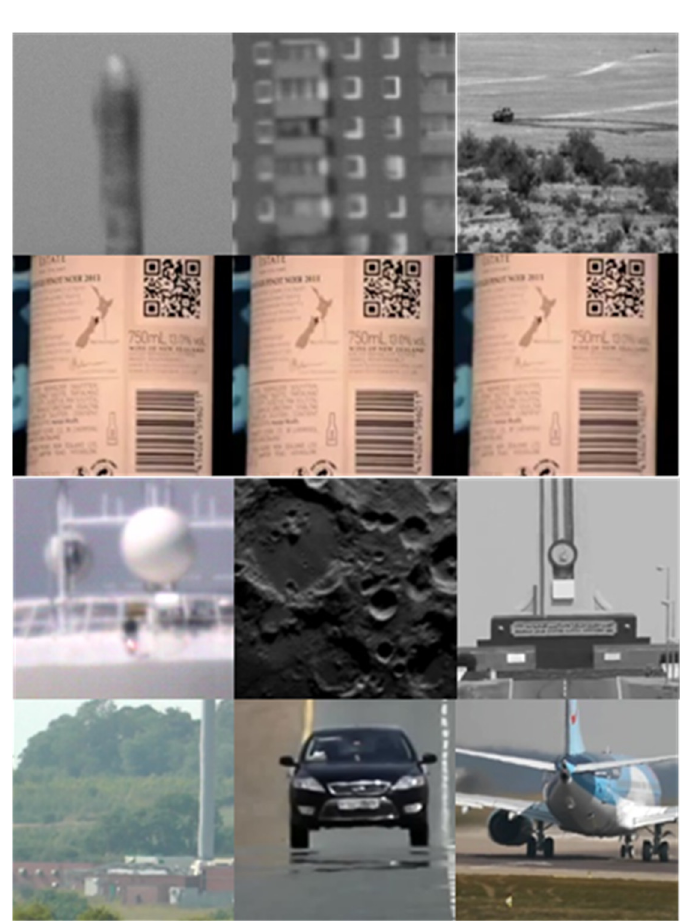
Figure 7. Sample frames from each video. First row: Chimney, Building, SENSIAC. Second row: Barcode #1–#3. Third row: Water tower, Moon, Monument. Fourth row: Secret base, Mirage, Air- port.